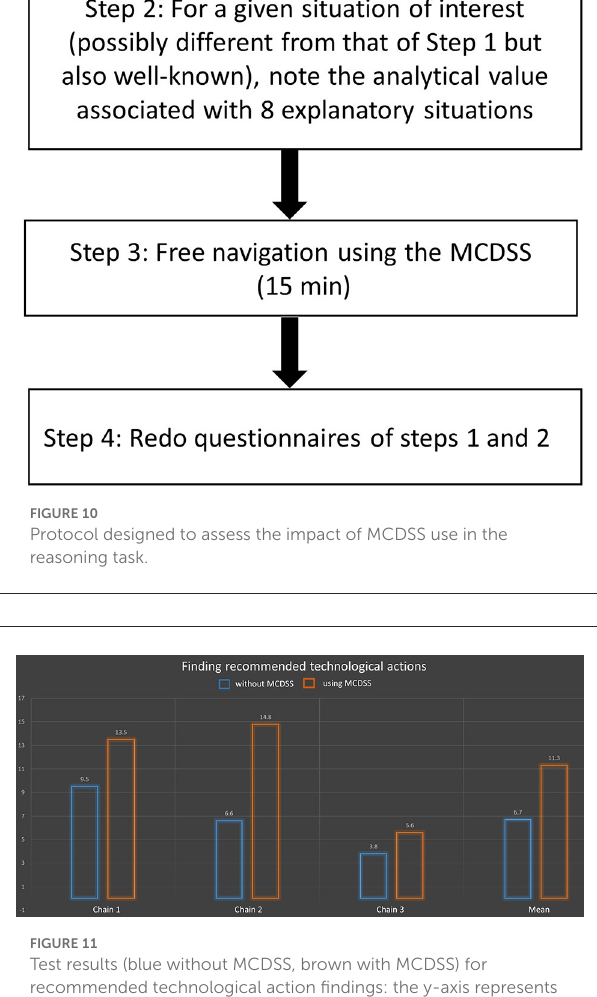
FIGURE11 Test results (blue without MCDSS, brown with MCDSS) for recommended technological action findings: the y-axis represents the number of correct answers (mean value) in the three chains and on